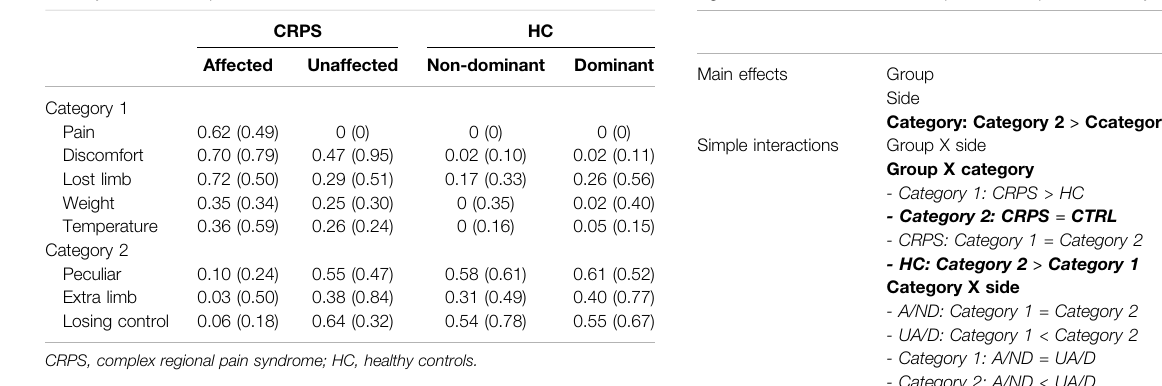
TABLE 2 | Mean (standard deviation) for Con fl ict Sensitivity for each item of the sensory disturbance questionnaire.